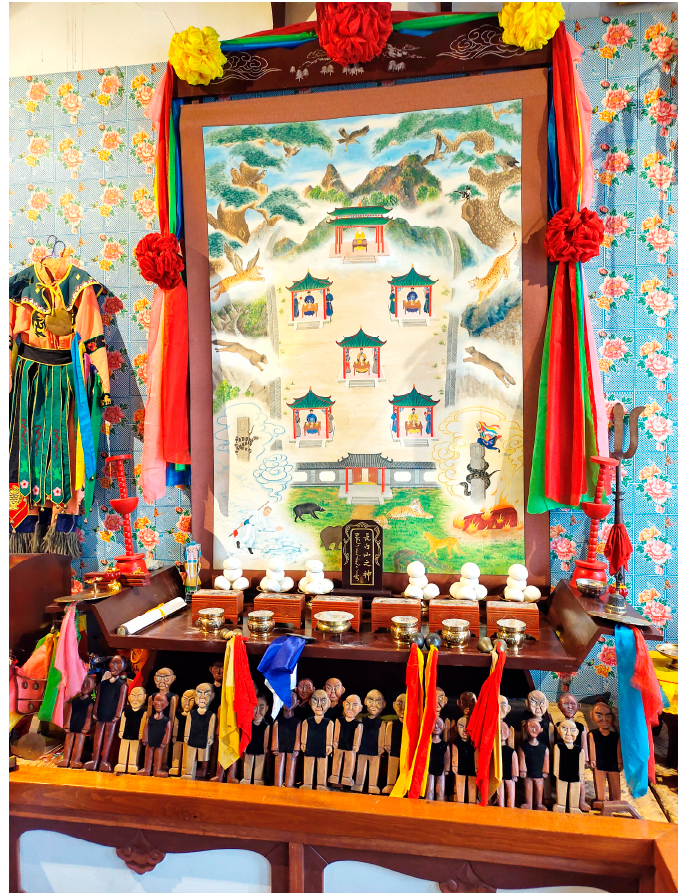
Figure 2. The spirit painting scroll and idols of the Shi clan exhibited in the Manchu Museum of Jinlin City. Photograph by Feng Qu in 30 January 2023.